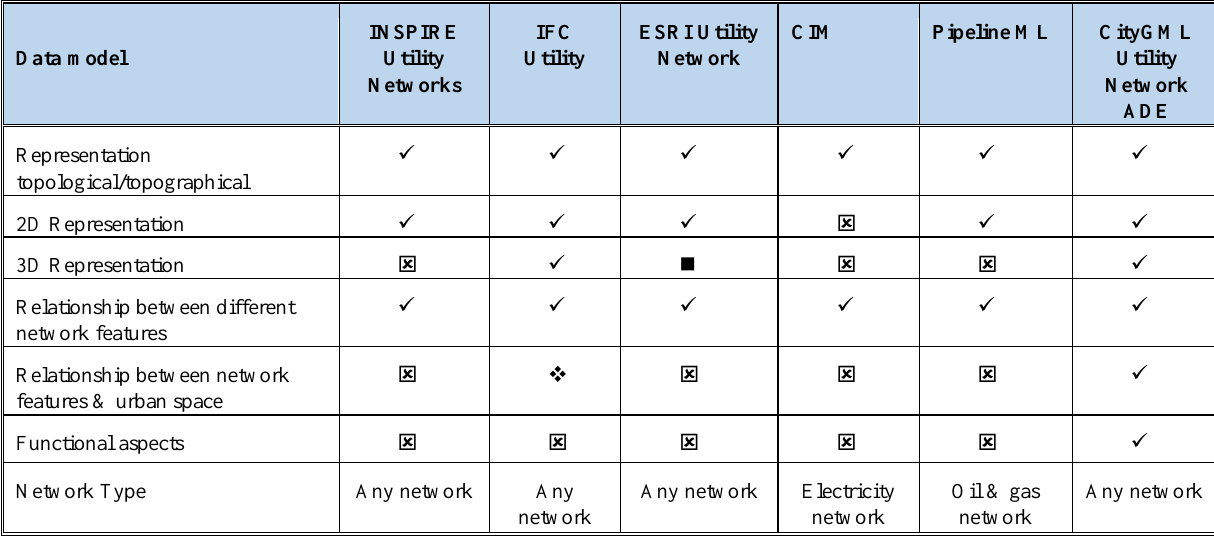
Table 1. Comparison between Network Data Models